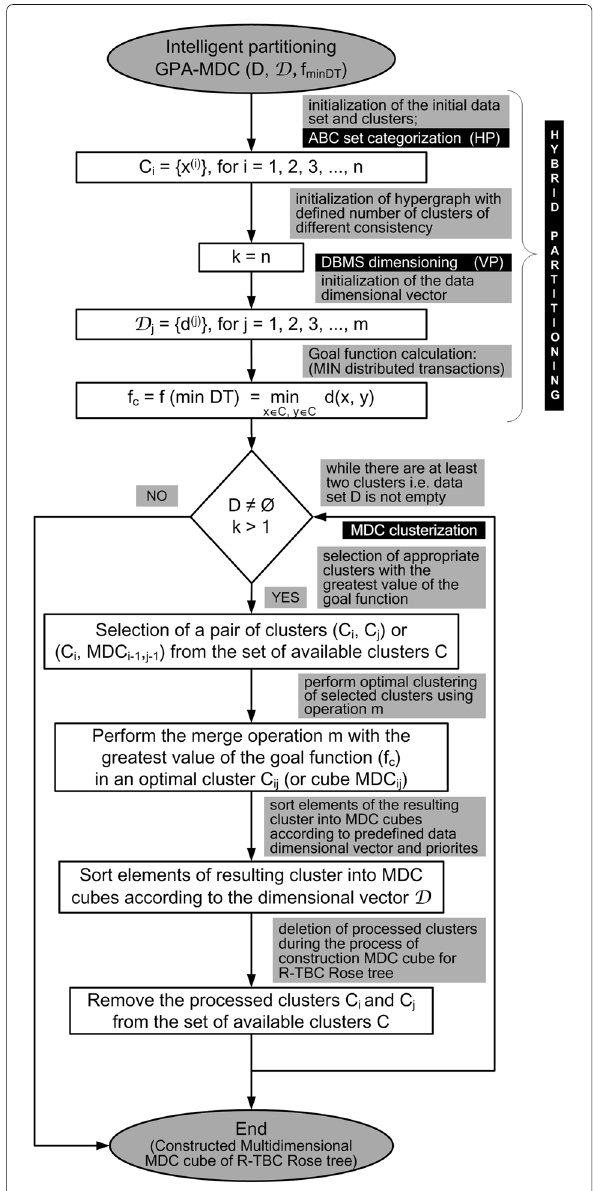
Fig. 7 GPA-MDC algorithm of intelligent partitioning for transactional database in a heterogeneous cloud environment